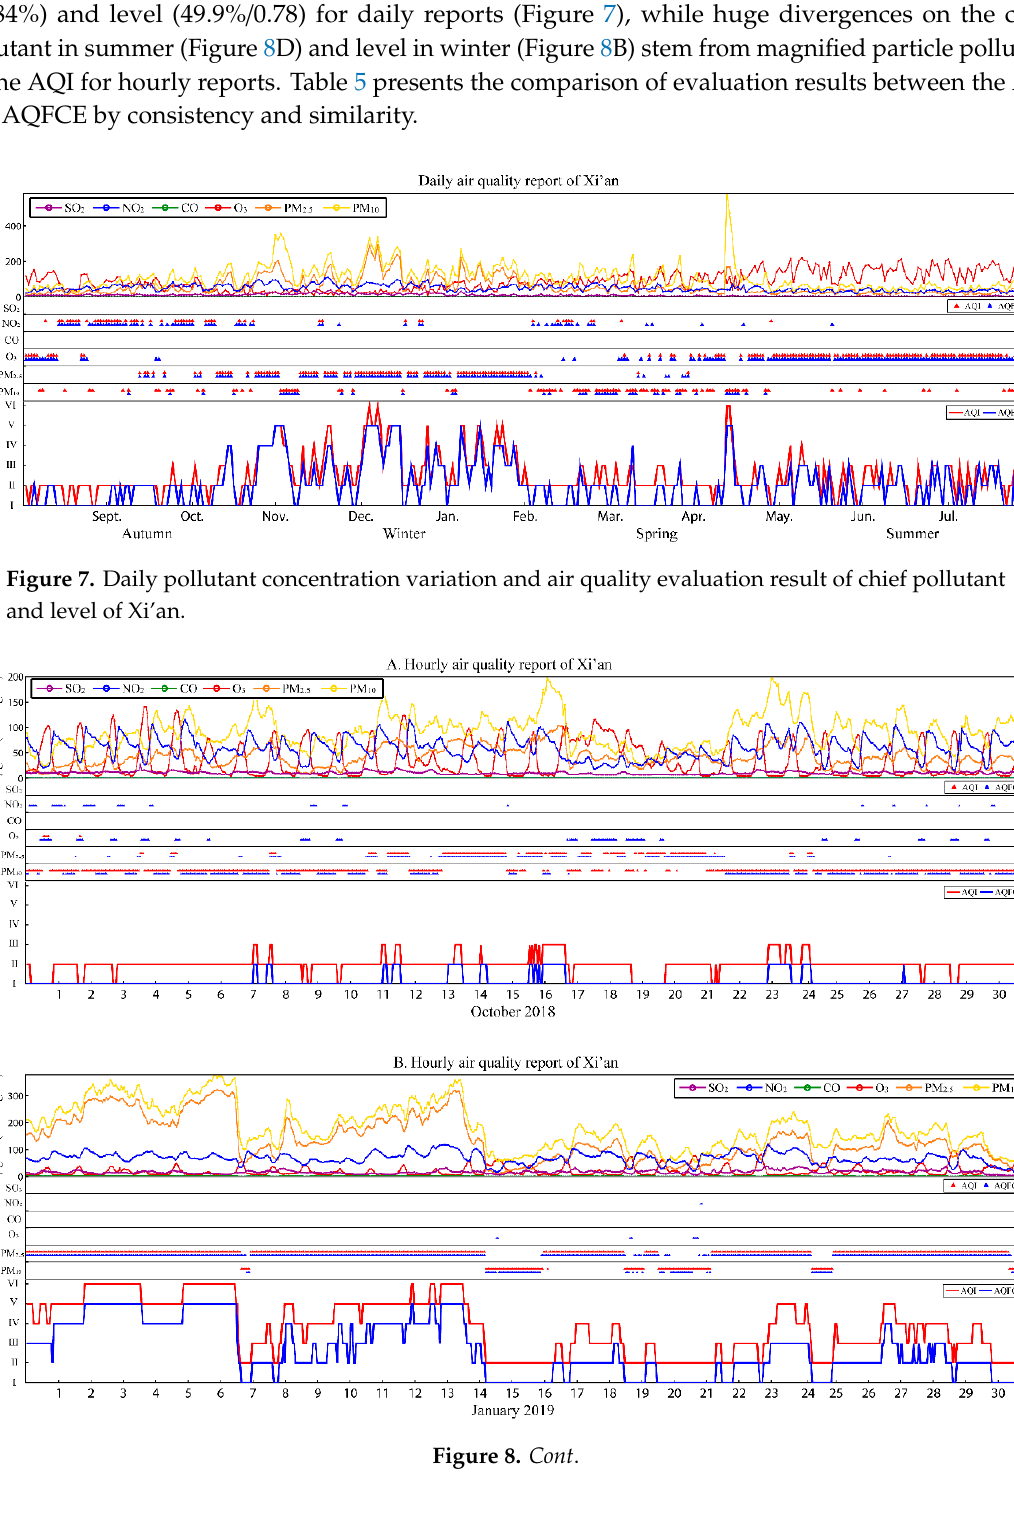
Figure 8. Hourly pollutant concentration variation and air quality evaluation result of chief pollutant and level of Xi’an.